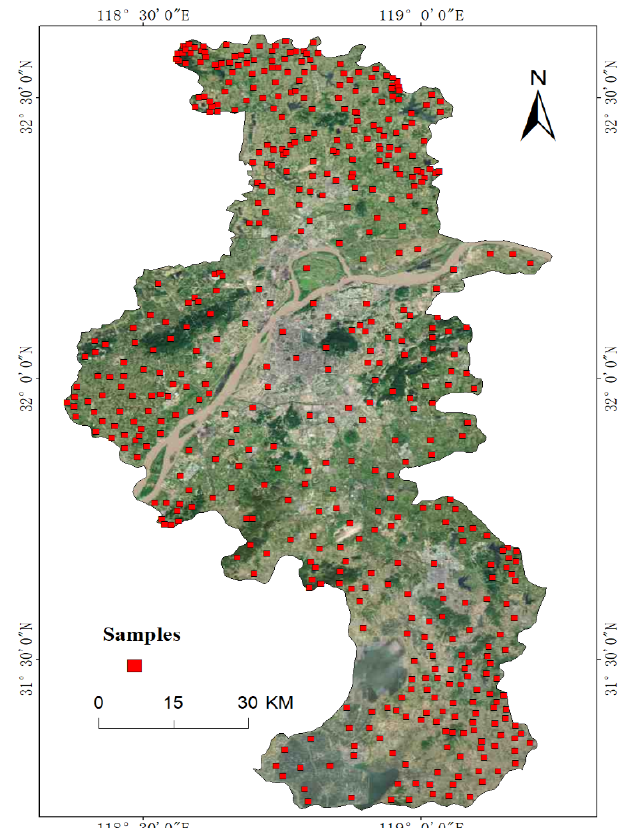
Table 2. Relationship between the coefficient of variation (CV) and the weight of evergreen trees in corresponding pixels. The CV value changes as the proportion of evergreen trees in the pixel changes.